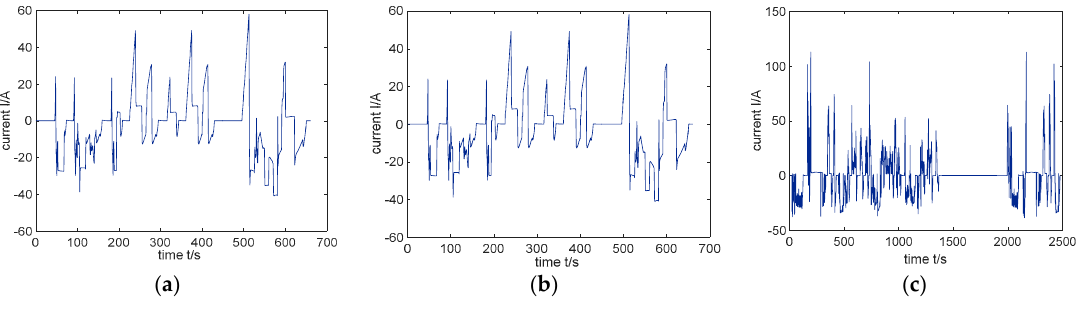
Figure 7. Current profiles of the tests: ( a ) current profile of the J1015 cycle test; ( b ) current profile of the New European Driving Cycle (NEDC) cycle test; and ( c ) current profile of the Federal Test Procedure-75 (FTP-75) cycle test.